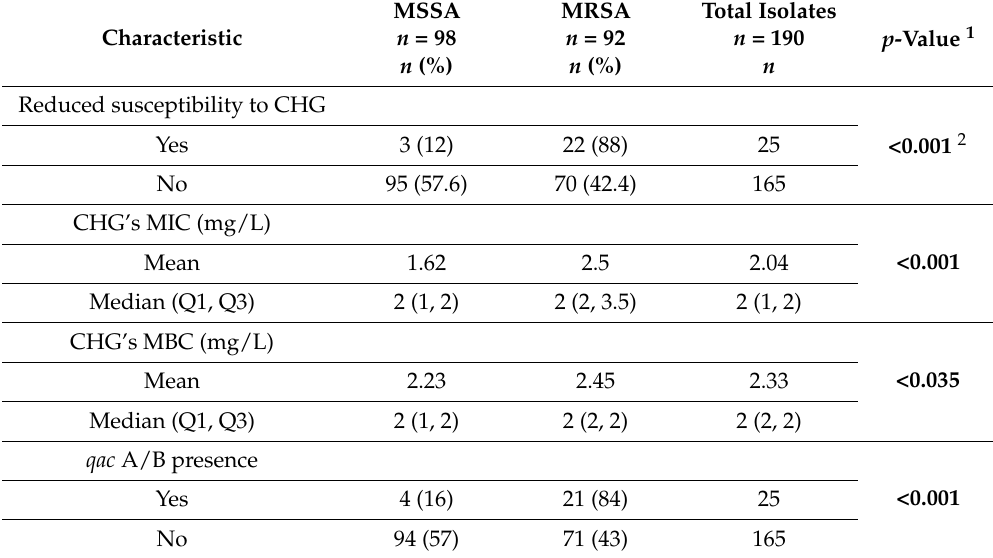
Table 2. Susceptibility to CHG among clinical